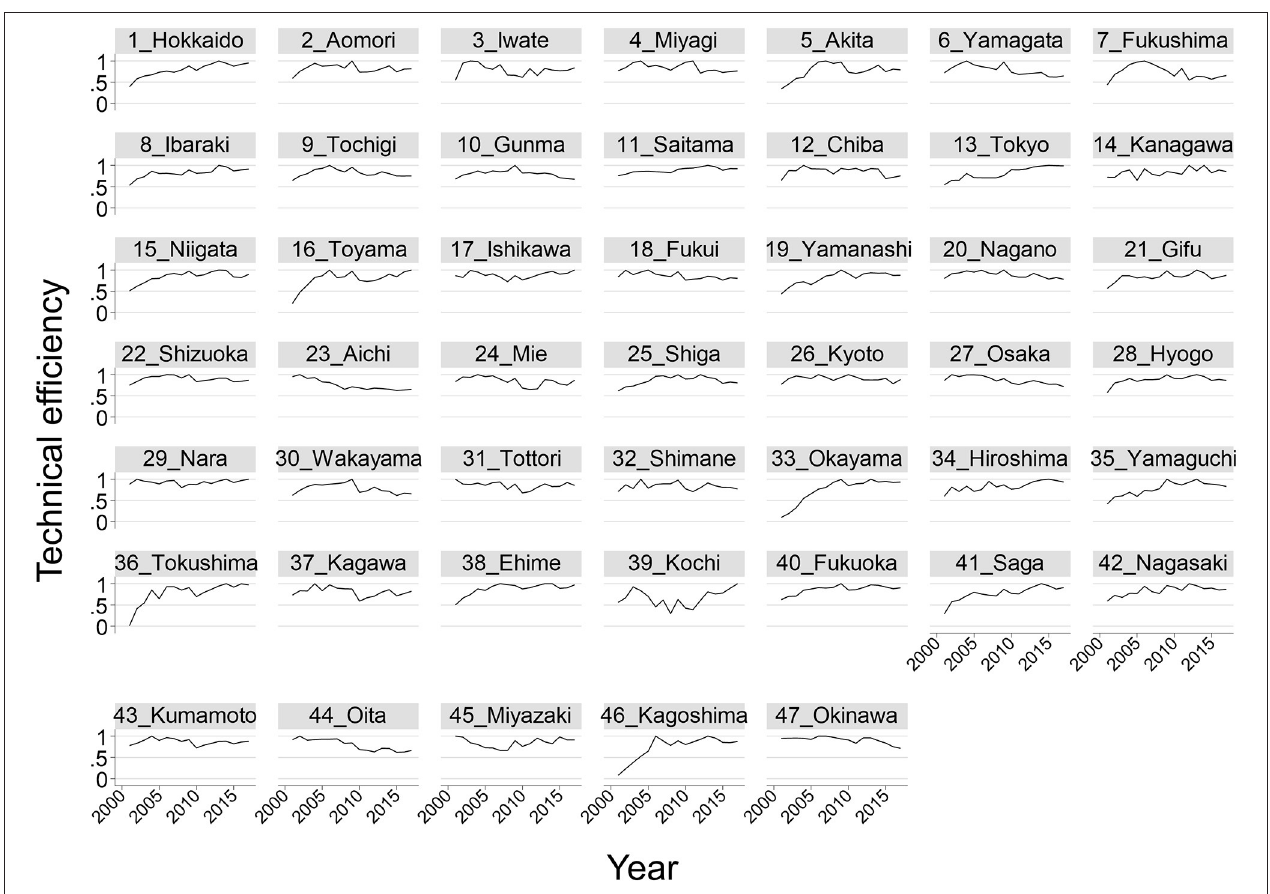
FIGURE 2 | Technical efficiency by prefecture from 2001 to 2017 based on the translog production function. The number listed before each prefecture’s name is the prefecture’s